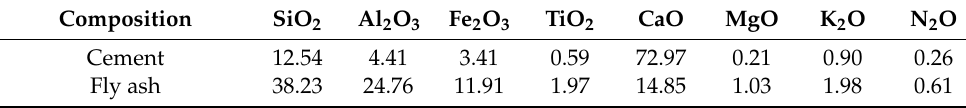
Table 1. Chemical compositions of cementitious materials (%) [27].